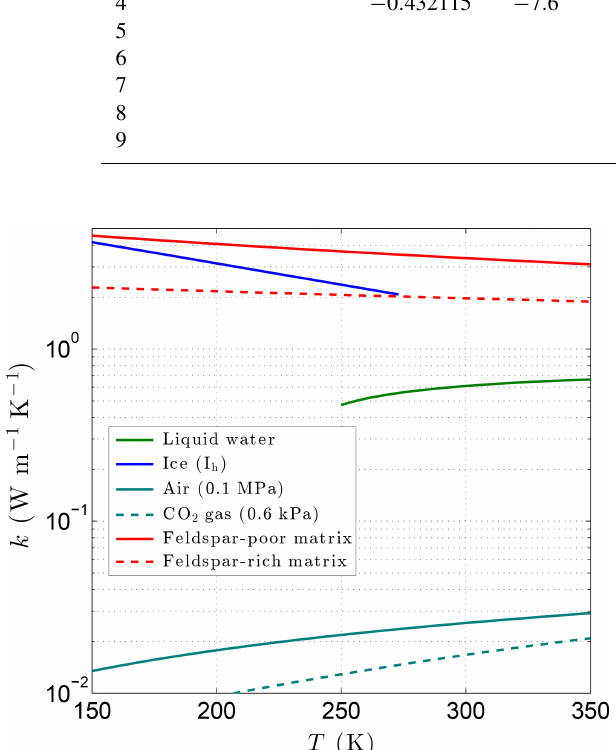
Figure 6. Variation of the thermal conductivity with temperature for liquid water, ice, air (terrestrial atmosphere), CO 2 gas (Mar- tian atmosphere), and magmatic/metamorphic matrix minerals with k ◦ m = 3 . 5Wm − 1 K − 1 (feldspar poor) and k ◦ m = 2 . 0Wm − 1 K − 1 (feldspar